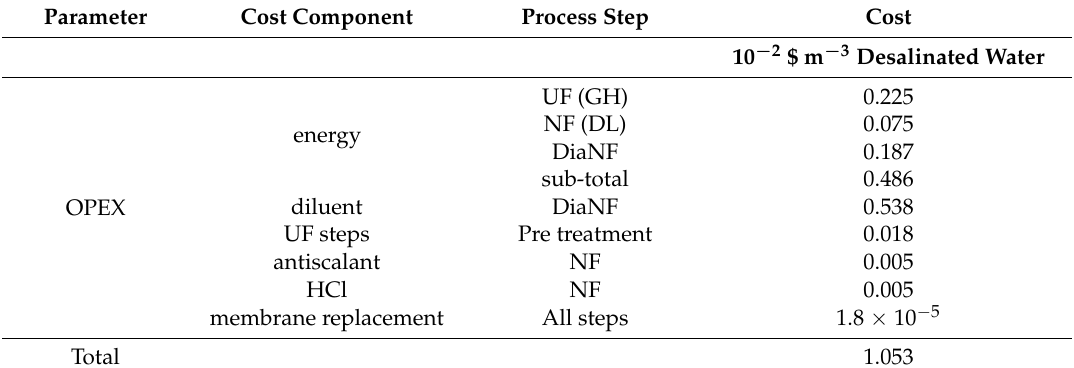
Table 9. Operational costs of applying the three-step process for adding 20 mgMg/L to desalinated water using counter current mode, and either 4 or 6 DiaNF